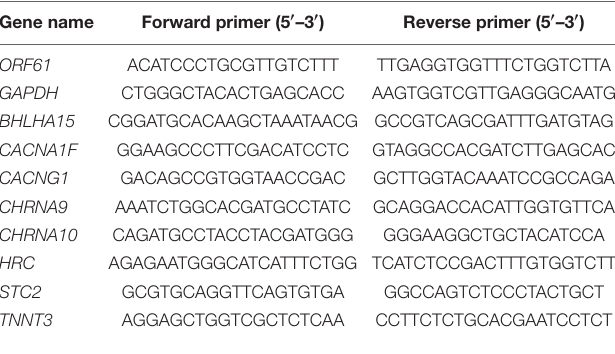
TABLE 1 | Sequences of the primer for quantitative real-time